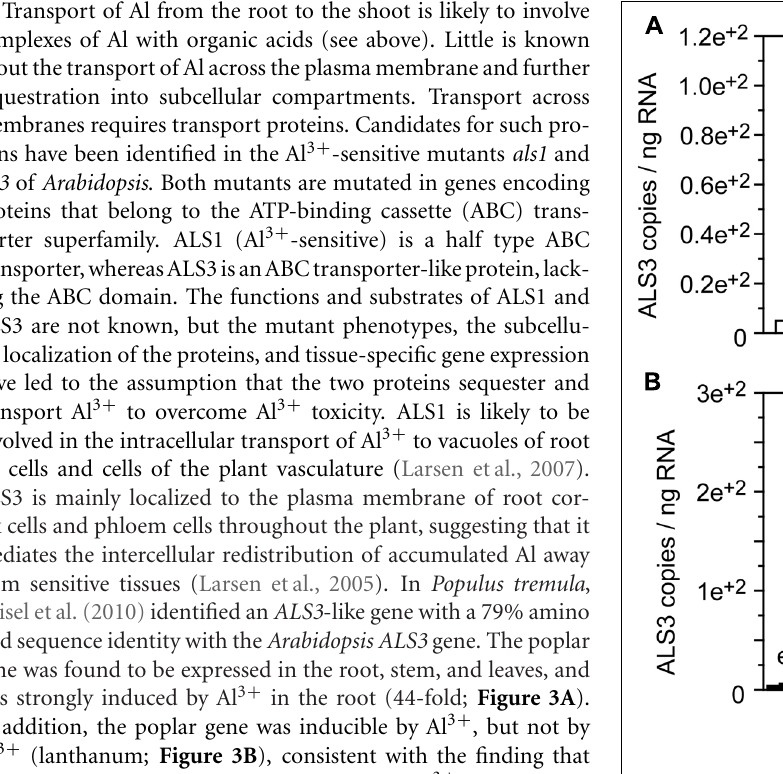
FIGURE 3 | Expression levels of ALS3 in tissues of Populus tremula treated withAl 3 + for 2 days. (A) Expression levels in root, stem and leaf tissue after treatment with 0 or 500 μ M Al 3 + . (B) Expression levels in the root tissue after treatment with 0, 50, 100, 250, 500, or 1000 μ M Al 3 + or La 3 + .Transcript levels were quantified by absolute qRT-PCR. Different letters indicate significant differences between treatments and elements: ANOVA; P < 0.05 (redrawn from Grisel etal.,